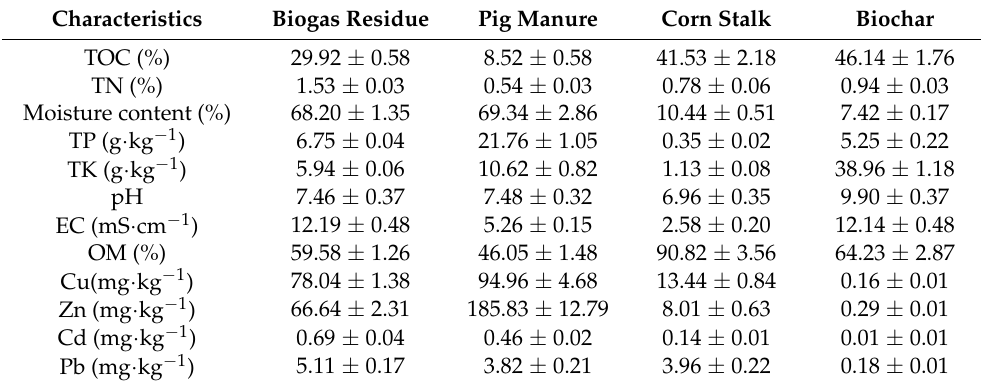
Table 1. Initial physical and chemical properties of composting materials.